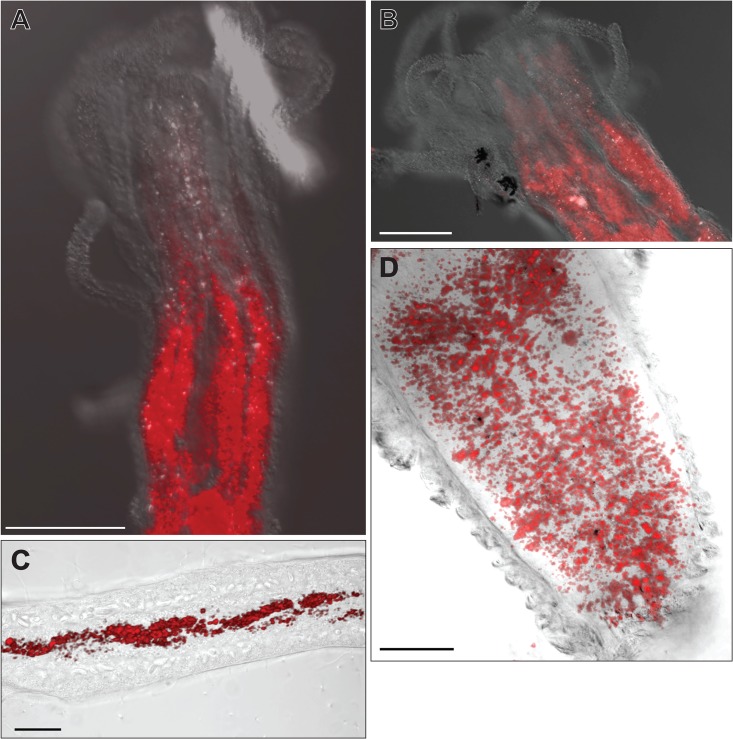
Distribution of label within digestive cells.(A) Feeding polyp. Projection of nine 6.5 μm optical sections. Scale bar = 100 μm. (B) Feeding polyp. Projection of ten 6.5 μm optical sections. Scale bar = 200 μm. (C) Stolon gastroderm. Scale bar = 20 μm. (D) Gastric cavity of reproductive polyp. Scale bar = 50 μm.